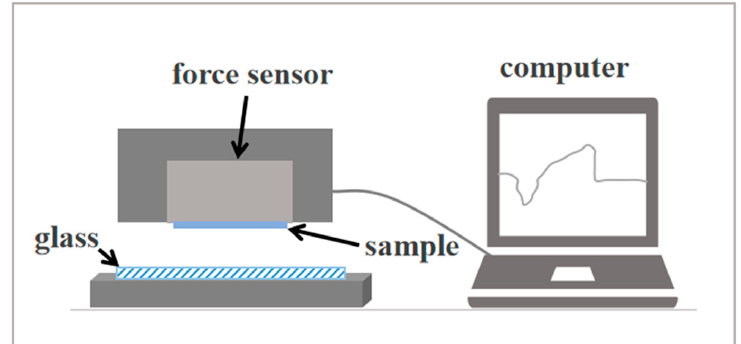
Figure 2. Schematic diagram of adhesion testing platform.